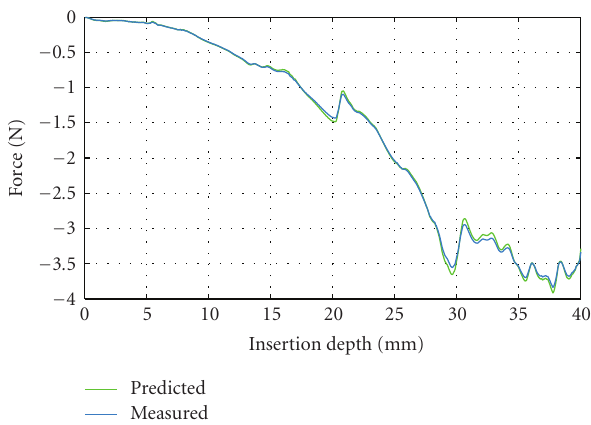
Figure 6: Insertion force prediction results using ANN for rep- resentative insertion: measured force (blue) and predicted force (green).